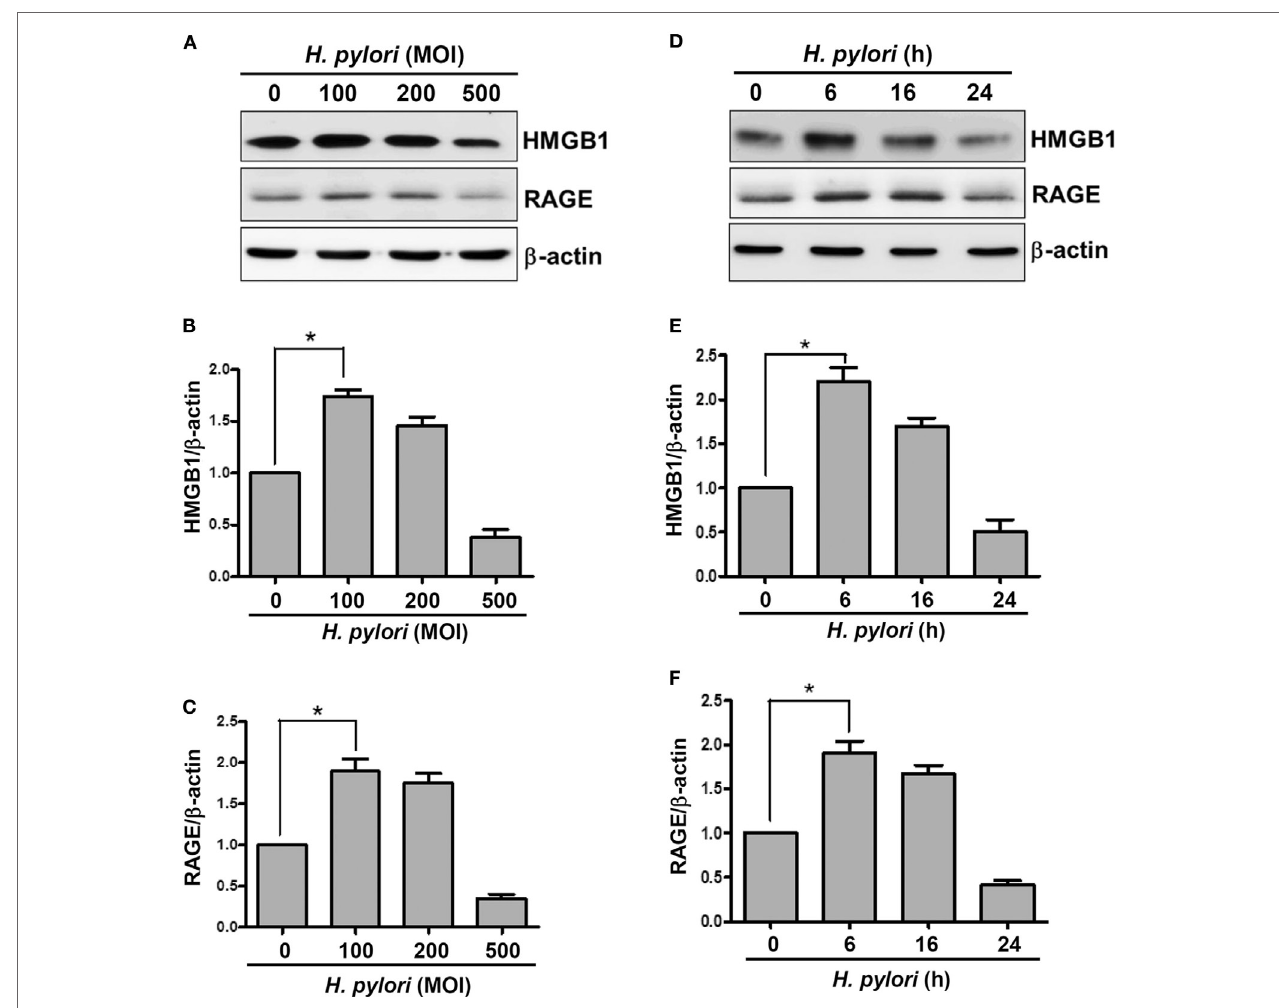
FigUre 1 | H. pylori induces hMgB1 and rage expression in gastric epithelial cells . AGS cells were infected with H. pylori for 6 h with various MOIs (a–c) , including an MOI of 100 at different time points (D–F) . Total cell lysates were prepared to evaluate HMGB1 and RAGE expression by Western blot analysis. Protein expression levels were quantified by densitometric analysis and normalized to β -actin (B,c,e,F) . Statistical significance was evaluated by Student’s t -test (* P <